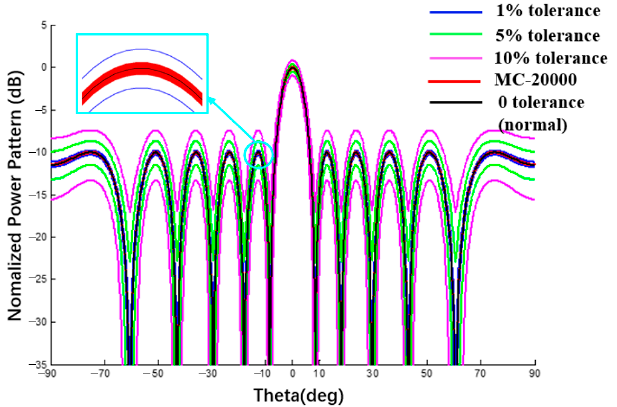
Figure 13. Linear array antenna pattern with excitation amplitude tolerance (Plane E, Dolph–Chebyshev excitation, the tolerance of MC method is 1%).